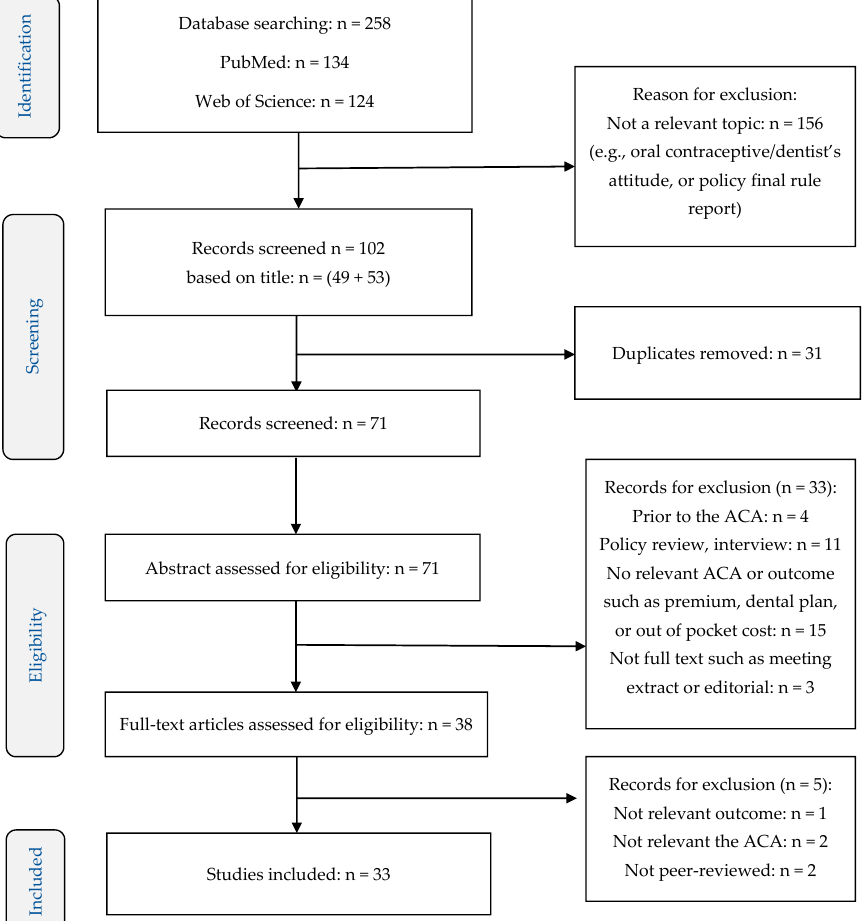
Figure 1. Flow chart of Study Selection.